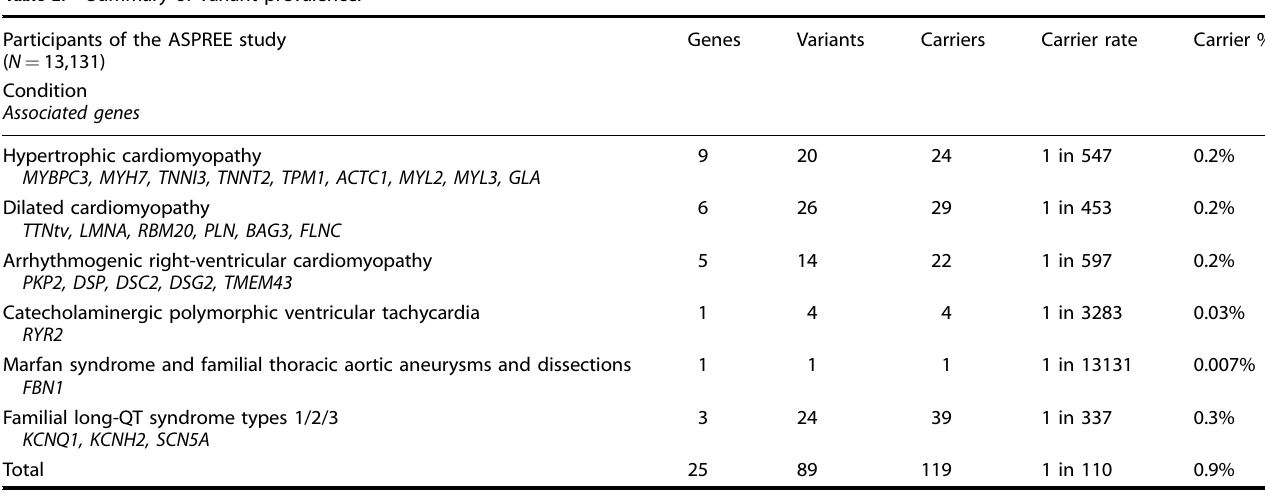
Table 2. Summary of variant